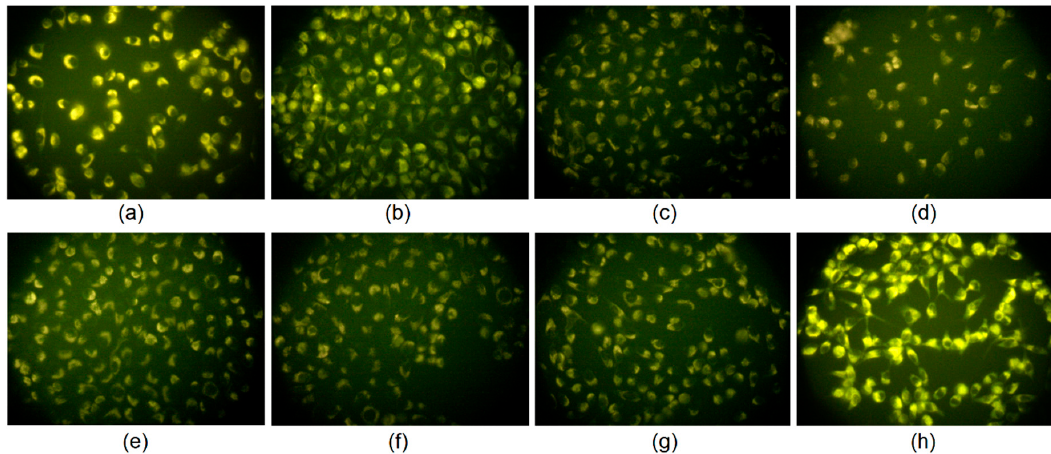
Figure 12. Mouse fibroblasts visualized using prepared CQDs: ( a )—CQDs-1; ( b )—CQDs-2; ( c )—CQDs-3; ( d )—CQDs-4; ( e )—CQDs-5; ( f )—CQDs-6; ( g )—CQDs-7 and ( h )—CQDs-8.